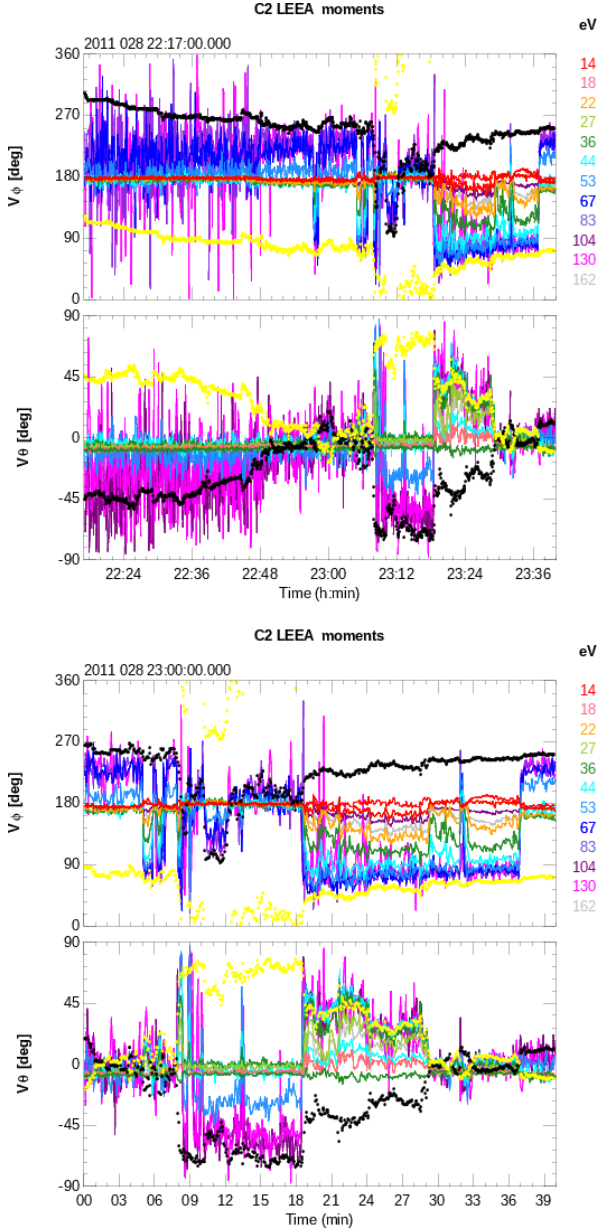
Figure 12. Upper plot shows the electron flow direction in GSE at 12 different energies over the full event time. Black and yellow lines are the spherical angles associated with the head and tail of the magnetic field. The lower plot shows a portion of the upper plot at a higher temporal